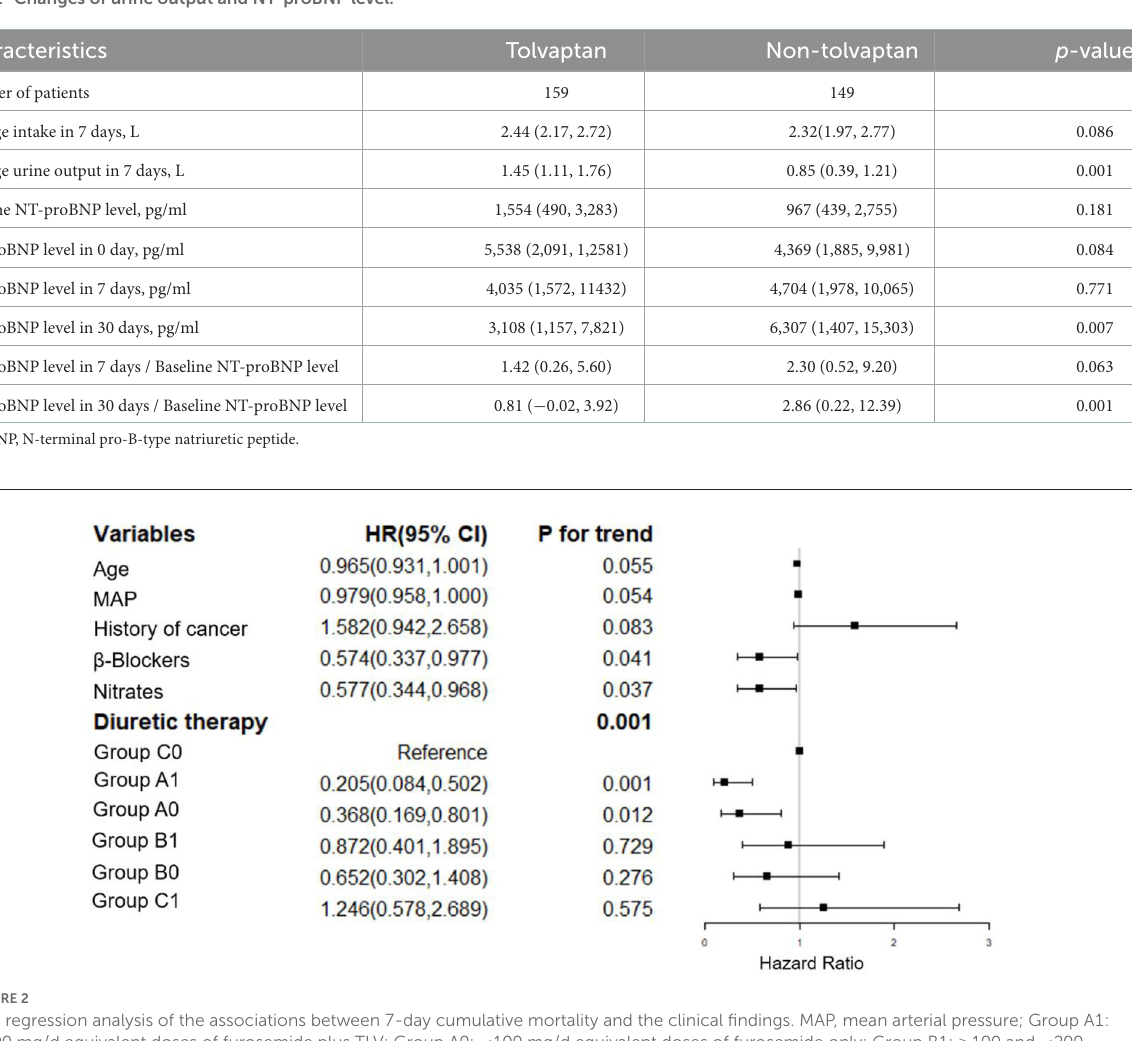
TABLE 2 Changes of urine output and NT-proBNP level.